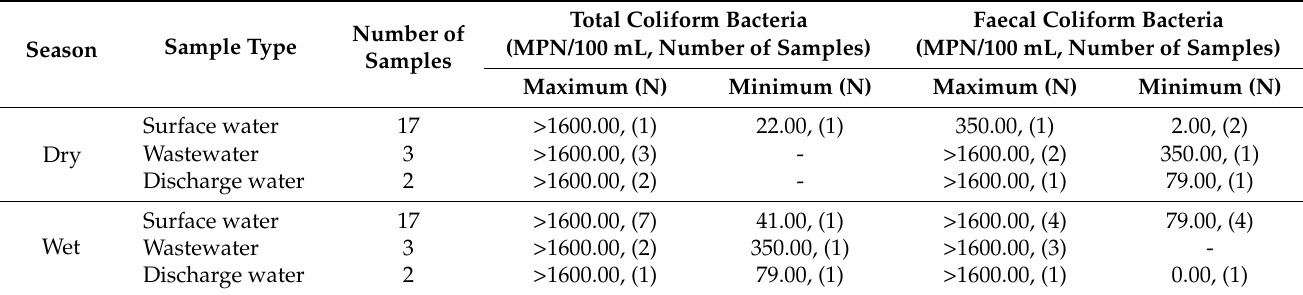
Table 1. Total coliform bacteria and faecal coliform bacteria.